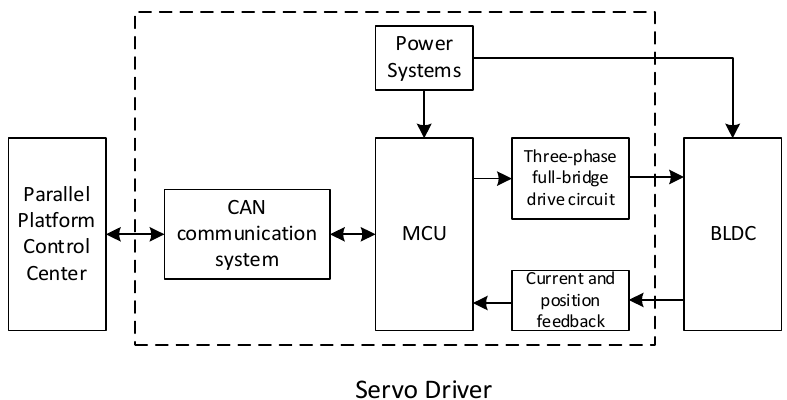
Figure 3. Block diagram of the driver hardware structure.